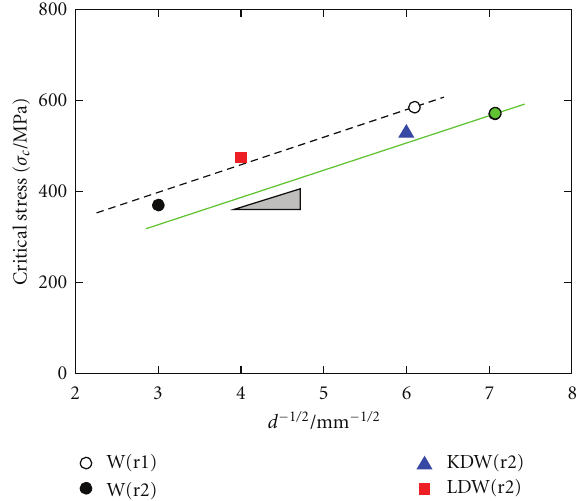
Figure 7: Grain size dependence of critical stress for various